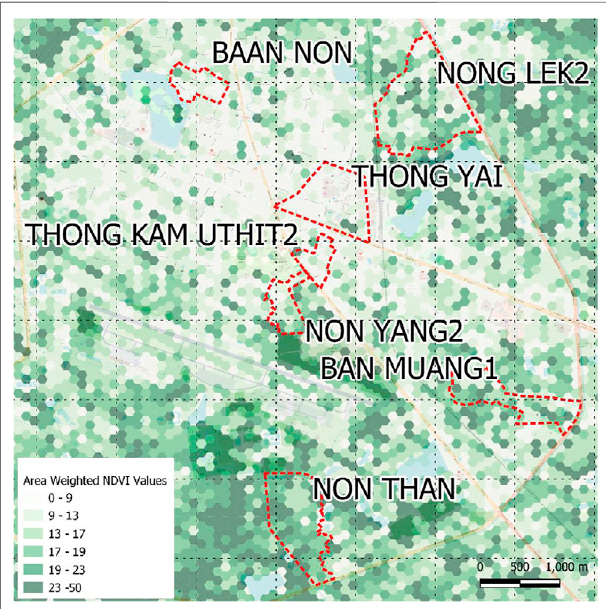
FIGURE 8 | Udon Thani Mean NDVI Jan-Dec 2018 (Landsat Imagery) [ source: http://climateengine.org/] Values have been visualized as mean area weighted NDVI values by 100 m hex grid derived from original 29 m